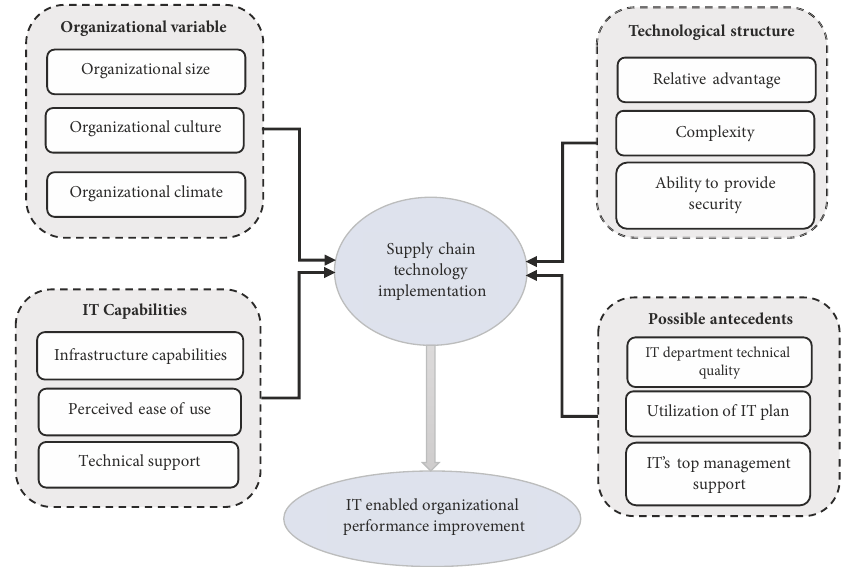
Figure 1. Model of